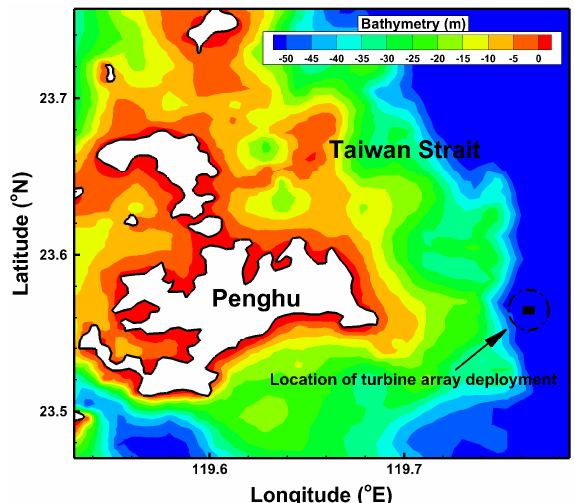
Figure 5. Location of the turbine